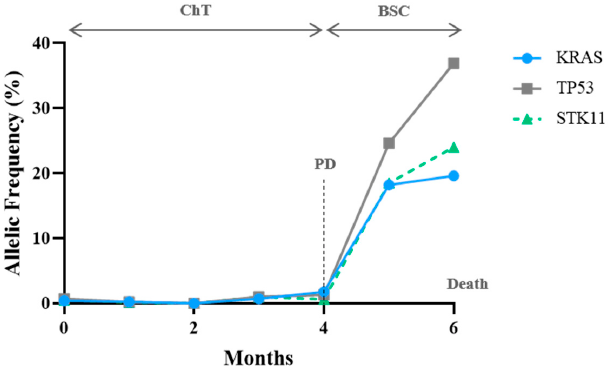
Figure 7. CtDNA monitoring in a KRAS/STK11/P53 mutant patient. At the 3rd cycle of chemother- apy (ChT), there was a proportional decrease in all detected variants. One month before RECIST progressive disease (PD), the patient displayed an increase in all variants, becoming exponential before death occurs. B